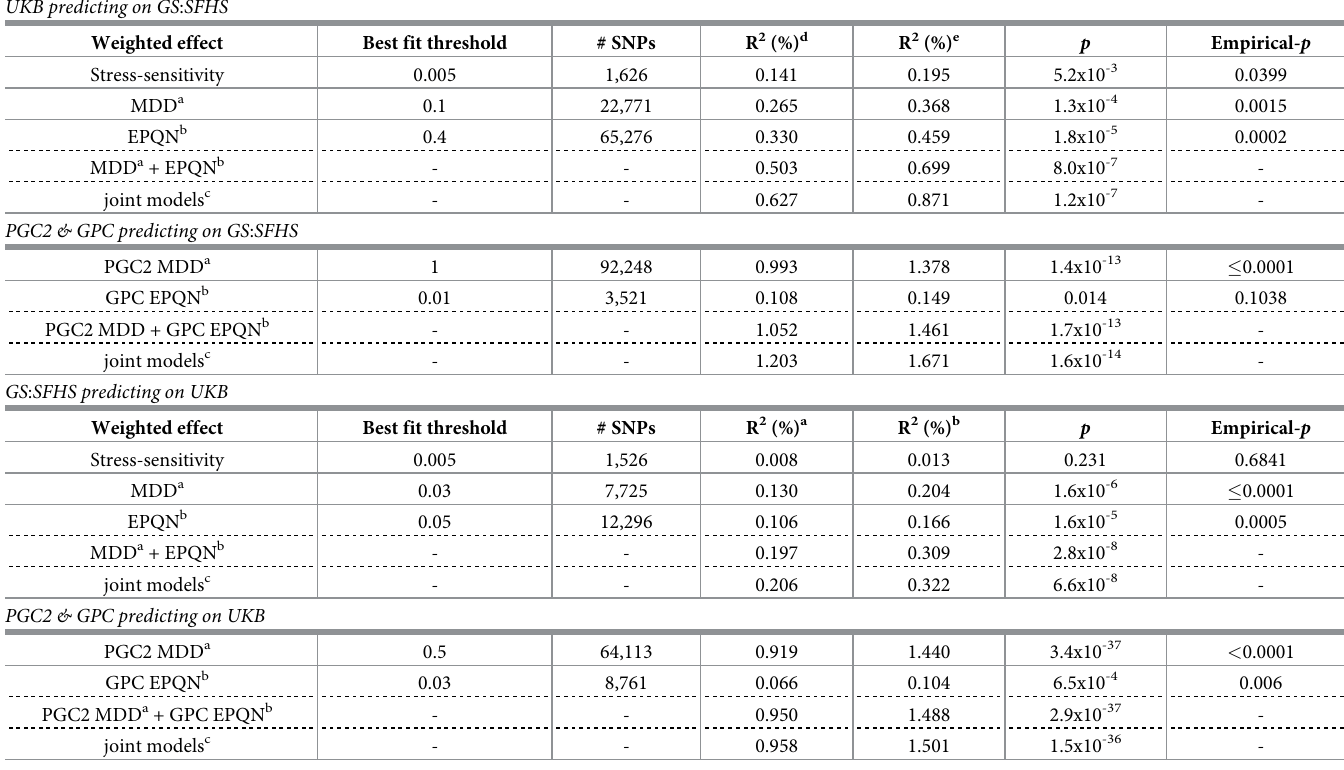
Table 2. MDD risk prediction at best